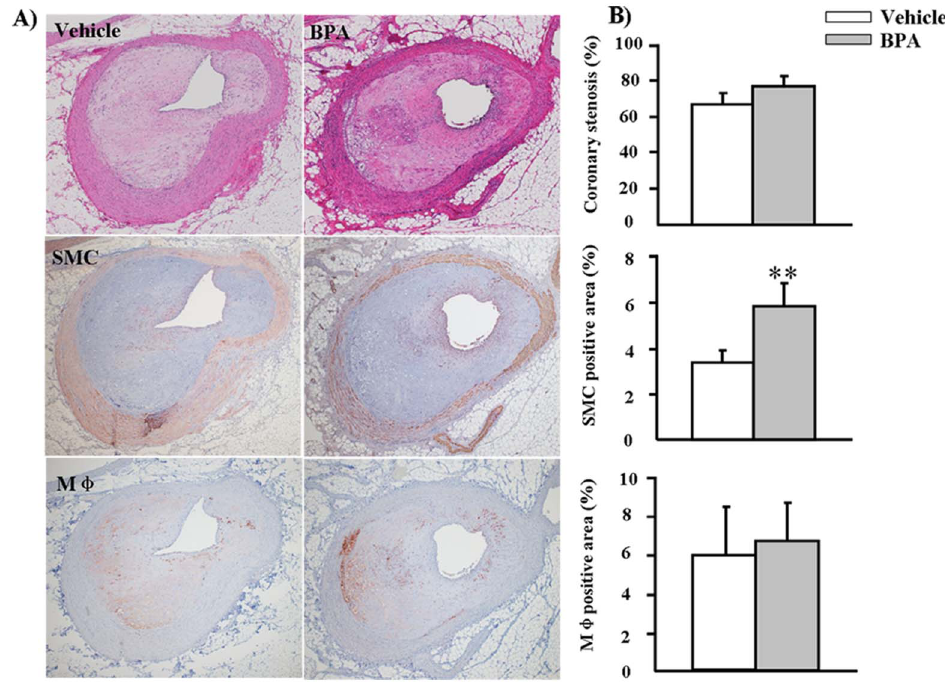
Figure 6. Microscopic analysis of atherosclerosis in the left coronary arteries of WHHL rabbits at 12 weeks. (A) Representative micrographs stained with H&E for coronary stenosis analysis are shown in the top panel. Representative micrographs stained with HHF35 and RAM11 mAbs for immunohistochemical analysis of SMCs and M Q are shown in the middle and lower panels. (B) Coronary stenosis, SMCs and M Q -positive areas of the sections were quantified using an image analysis system as described in the Materials and Methods section. Data are expressed as the means 6 SD, n=6 for each group. ** p , 0.01 vs. vehicle. Original magnification: 4 6 .